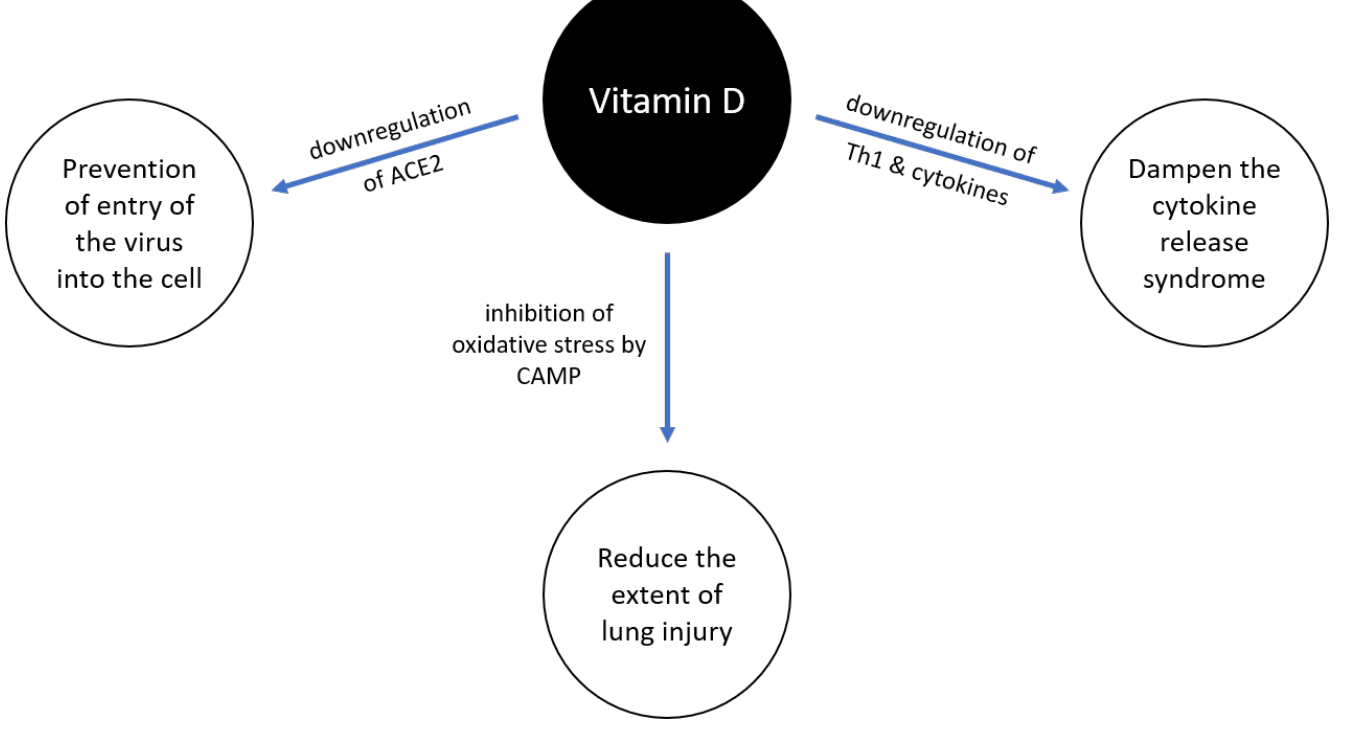
Figure 1. Possible mechanisms for the protective role of vitamin D in coronavirus disease 2019 (ACE2, angiotensin-converting enzyme 2; CAMP, Cathelicidin antimicrobial